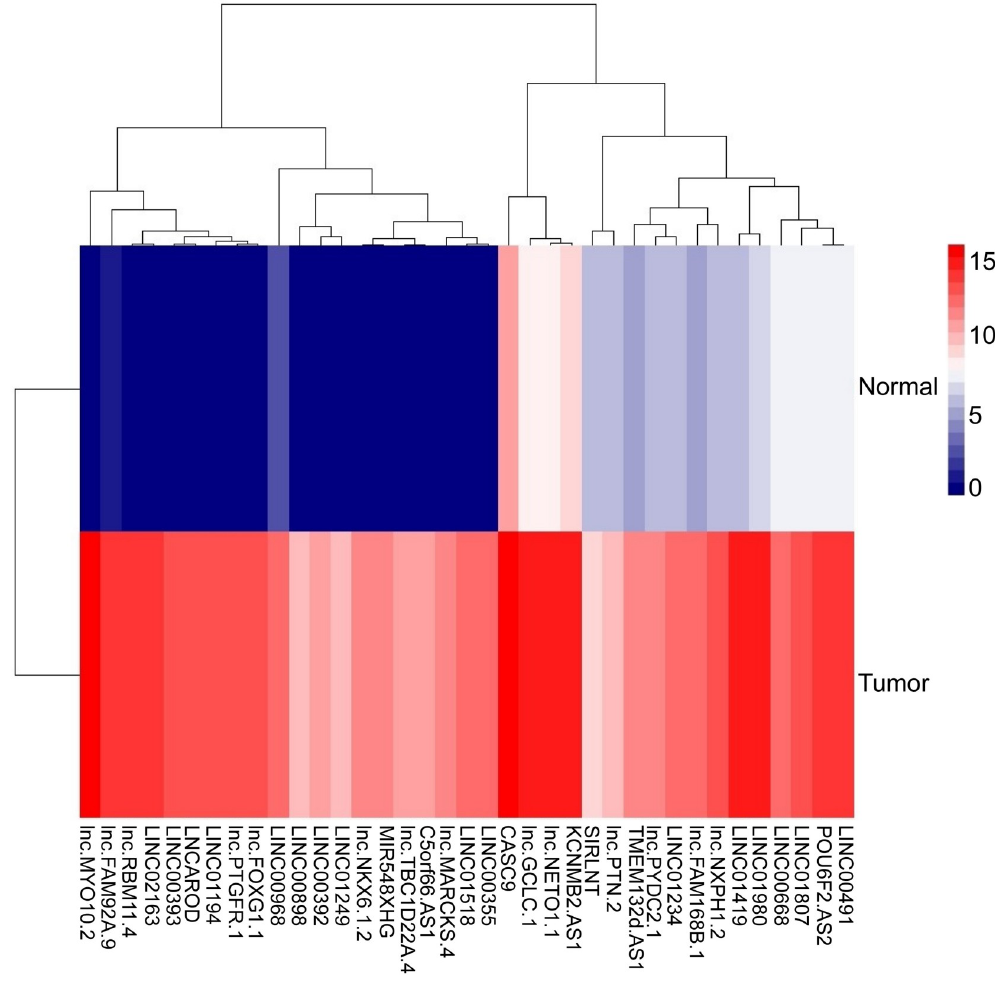
Fig 2. Cluster heat map of differentially expressed lncRNA in cancer tissues and adjacent tissues. The abscissa represented the differential lncRNA, and the ordinate represented the sample. The color of the heat map corresponded to the expression of lncRNA. Red indicated high expression, blue indicated low expression, p <